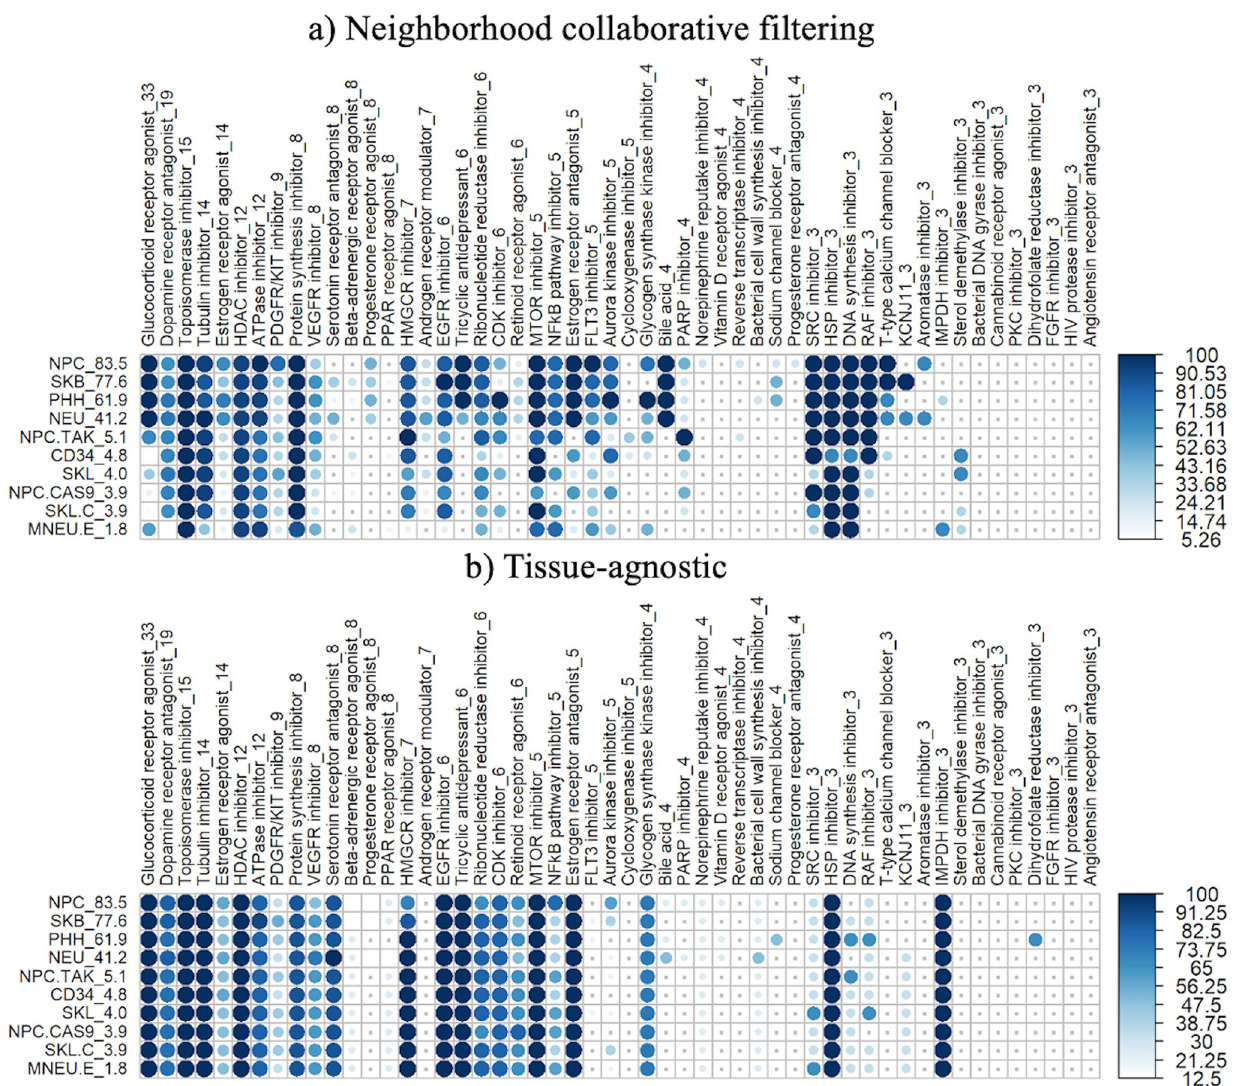
Fig 6. Recovery of imputed related drugs, by drug class and cell. a) Percent of drugs correctly expressing strong connectivity to their drug class using the fully imputed sparse matrix by the neighborhood approach, for primary cells only. The number of drugs in each PCL set is included in the PCL name, and the percentage of drugs assayed in each cell type is included in the cell name. Darker and larger dots correspond to a the higher percentage of drugs with statistically significant NCS values (Section 2.5.1). Tiny grey dots represent PCL/cell combinations in which there were no statistically significant NCS values. Plots were generated using the corrplot package [26]. b) Percent of drugs correctly expressing strong connectivity to their drug class using the fully imputed sparse matrix by the tissue-agnostic approach, for primary